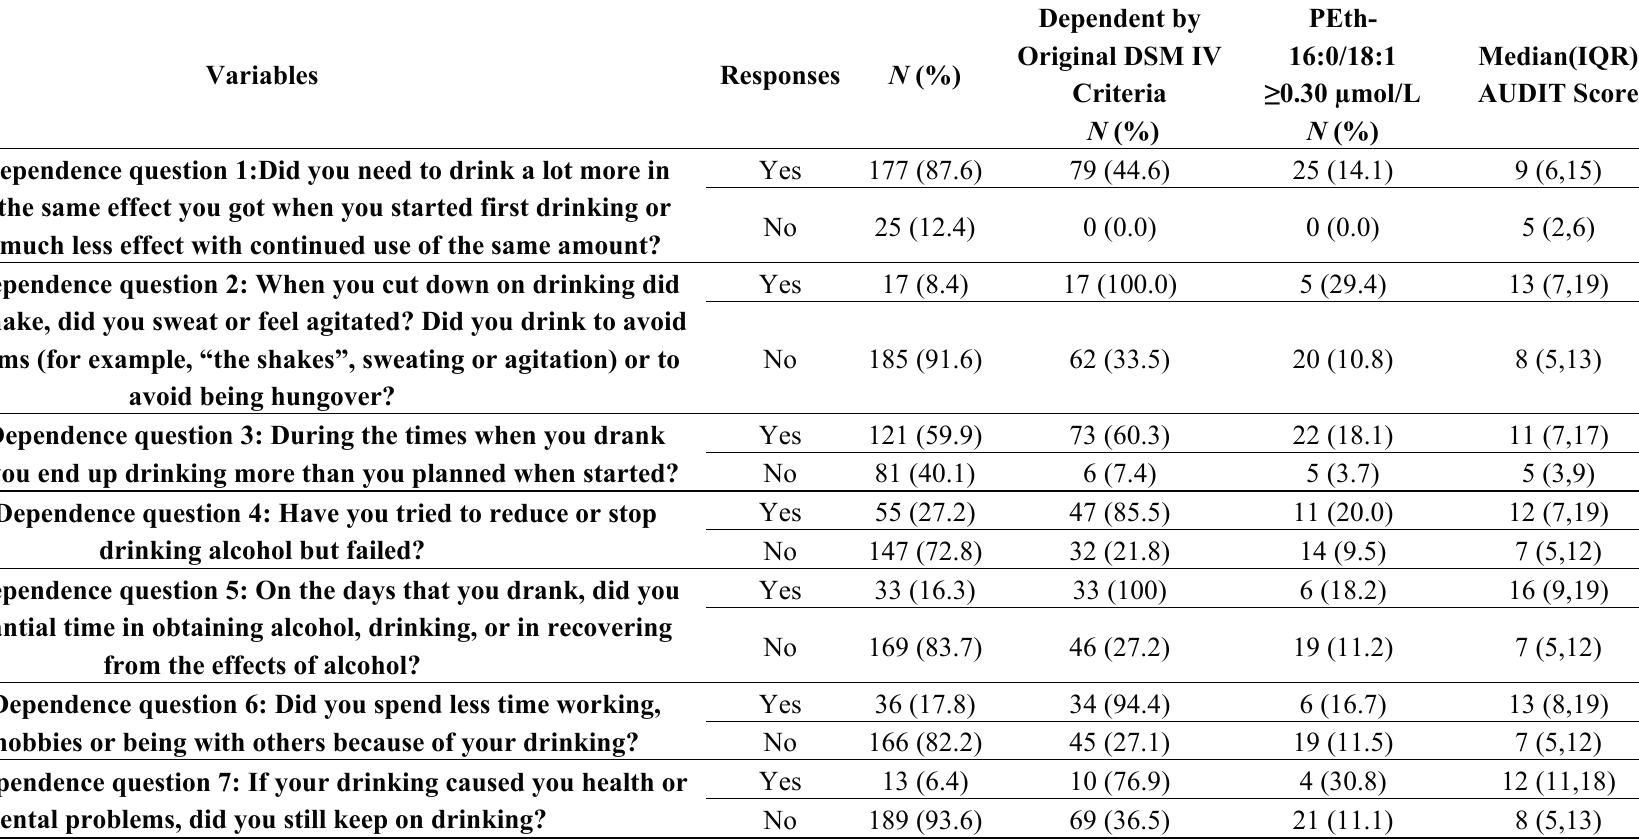
Table 2. Responses to MINI DSM IV questions compared to AUDIT scores and PEth test